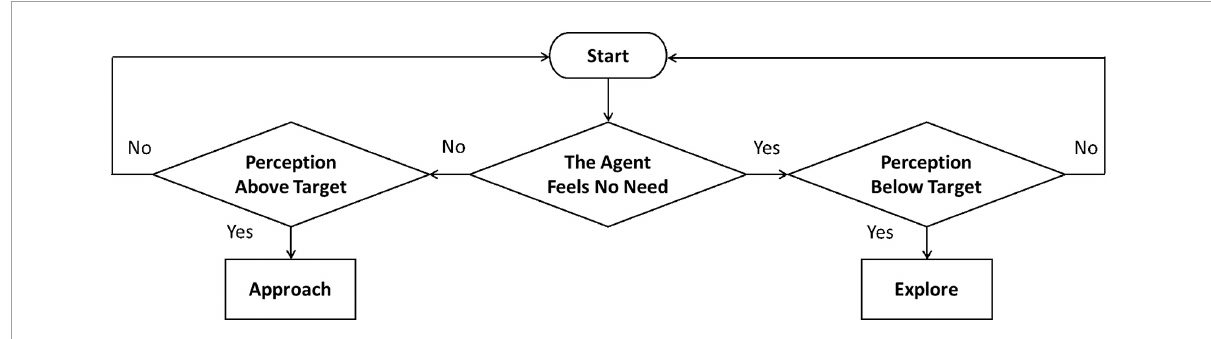
FIGURE7 Action selection rule. An action is selected depending on the comparison between current and target dimensional levels.